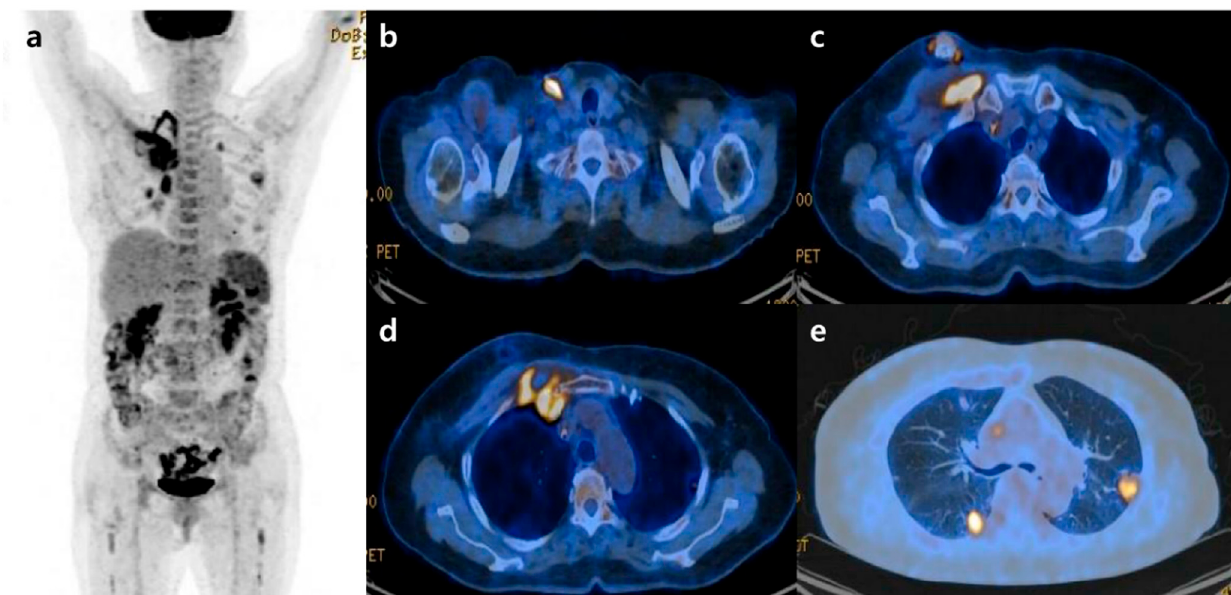
Figure 2. 18 F-FDG PET/CT images ( a ) showed abnormal FDG uptake in the chemo-port catheter ( b ), right pectoralis muscle ( c ), and the anterior thoracic wall around the first costochondral junction, consistent with an inflammatory/infectious process ( d ). Lung window setting image, showing multiple cavitating hypermetabolic nodules in both lungs consistent with septic pulmonary emboli ( e ). According to these findings, the patient was suspected of having catheter-related bloodstream infection and septic pulmonary emboli.